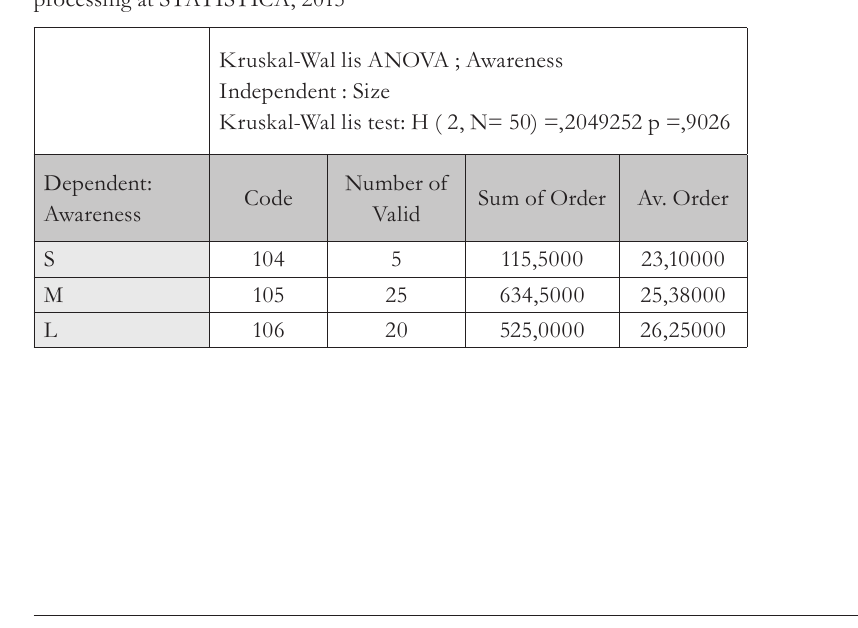
Tab. 4 – Kruskal-Wallis test, Awareness and Size (Small, Medium, Large), Source: